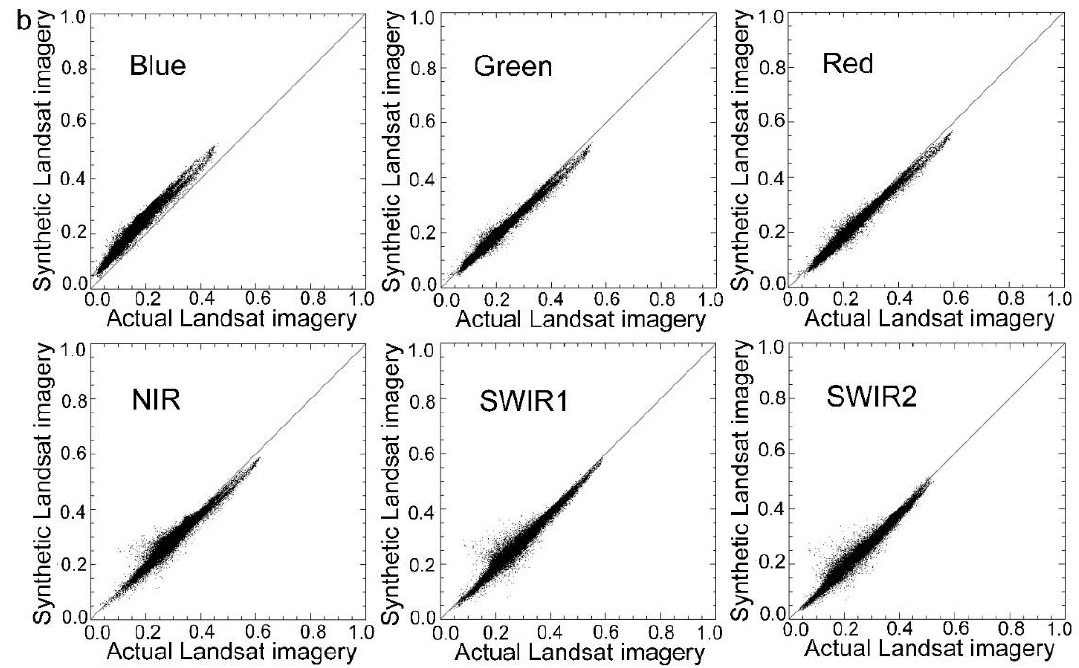
Figure 4. Scatter plots between the actual and synthetic imagers of Landsat at ( a ) Bole and ( b ) Luntai by using the modified spatial and temporal data fusion approach